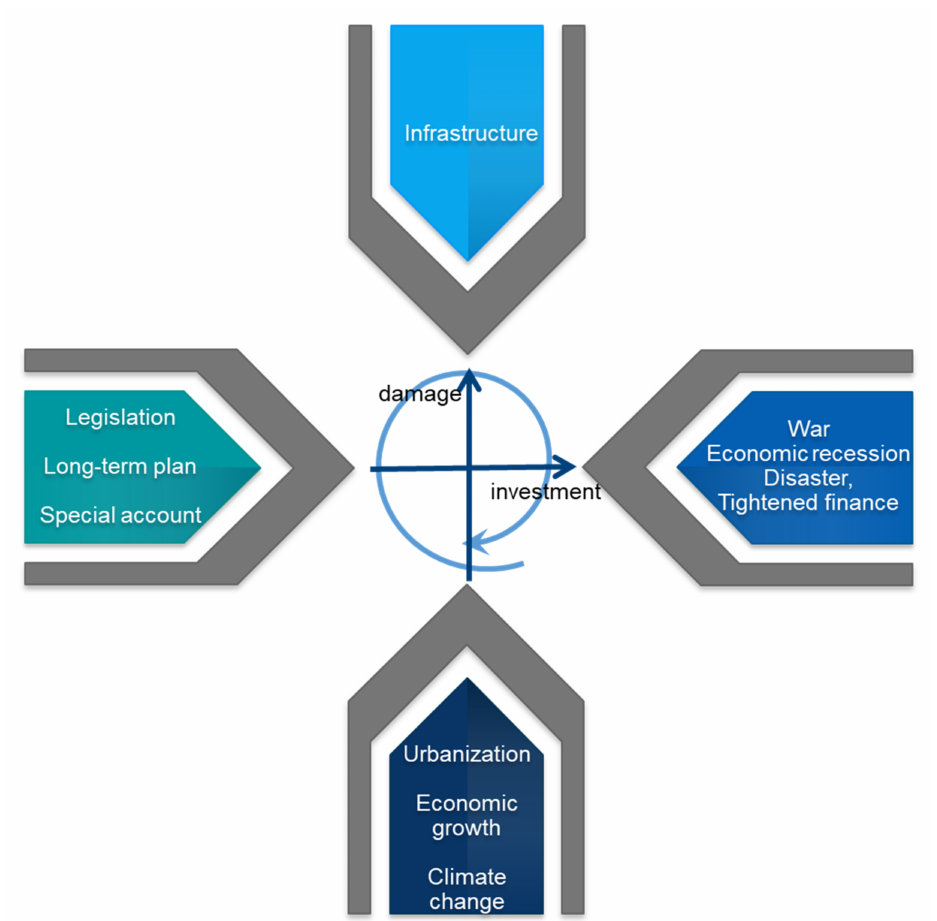
Figure 9. Factorsaffectingflooddamageandinvestmentforfloodprotection. Source: